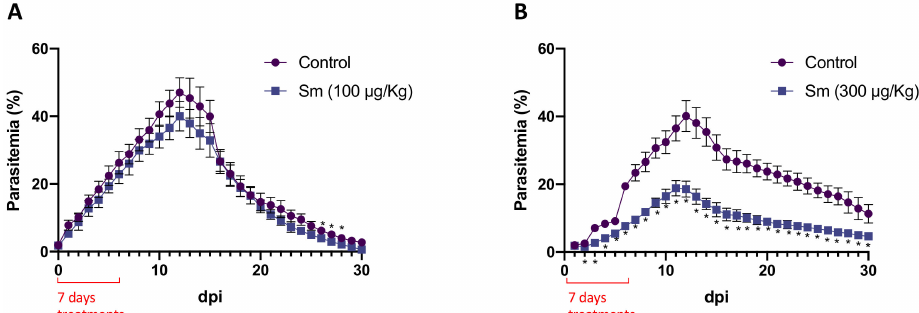
Figure 4. Effects of 7 days of sparsomycin (Sm) treatment on C57BL/6 mice infected with P. yoelii 17XNL. ( A ) Parasitemia levels after treatment with 100 µ g/kg Sm and ( B ) parasitemia levels after treatment with 300 µ g/kg following the inoculation of 1 × 10 7 infected erythrocytes. Each group consisted of six mice. *: the significance of differences in the level of parasitemia in Sm-treated mice compared with control mice was analyzed by two-way ANOVA followed by Sidak’s multiple comparison test ( p <